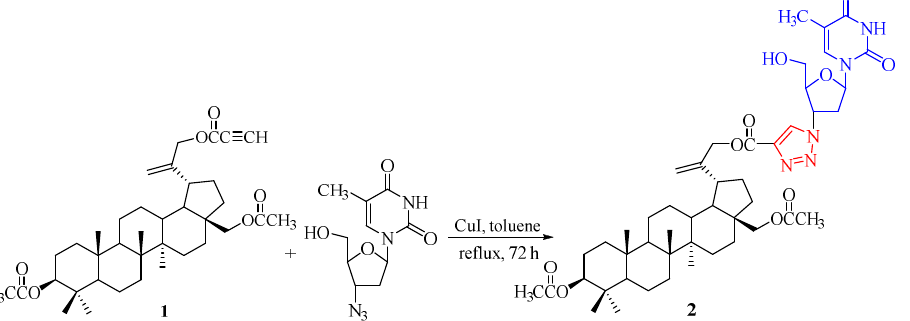
Figure 1. Chemical structure of azidothymidine (AZT) and 1,2,3-triazole derivative [13].